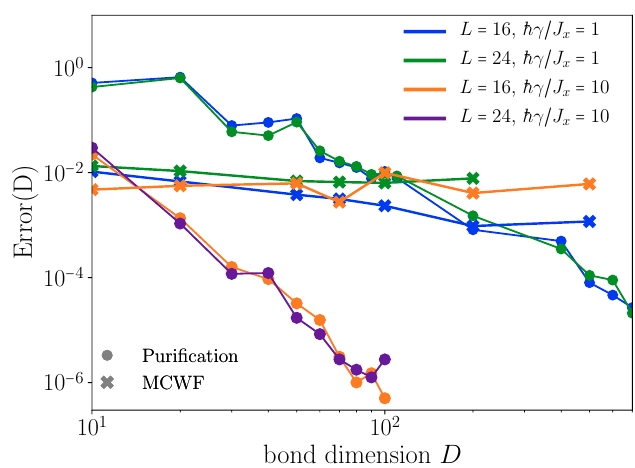
Figure 15: Comparison of the two-time correlation functions error (Error ( D ) ) calcu- lated in the purification method and the MCWF approach introduced by Breuer et al. / J = 2 and t / (cid:126) = 5. For the purification data a time step of ∆ tJ / (cid:126) = 0.05 J for J z x x x 1 / (cid:126) = 0.02 for (cid:126) γ/ J = 1 and has been used and for the MCWF method ∆ tJ x x ∆ tJ / (cid:126) = 0.002 for (cid:126) γ/ J = 10. As a reference to calculate the ∆ used in x x max = 900 for (cid:126) γ/ J = 1 and D = 110 for (cid:126) γ/ J = 10 Error ( D ) we choose D x x max max = 1000 with for the purification method. For the MCWF approach we consider D max = 1, D = 1000 with R = 2500 for L = 16 and R = 10 4 for L = 16 and (cid:126) γ/ J x max (cid:126) γ/ J = 10 and D = 500 with R = 300 for L = 24 and (cid:126) γ/ J = 1. x x max